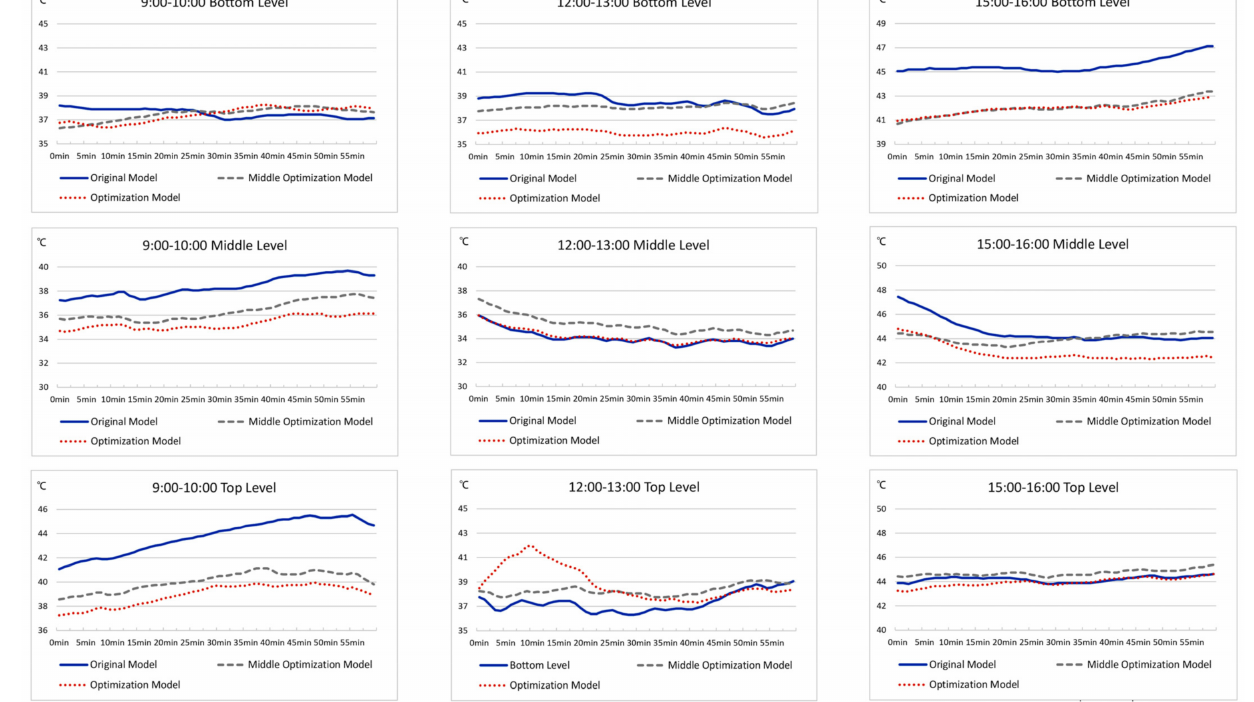
Figure 25. The temperature comparison of original, optimized, and best-optimized